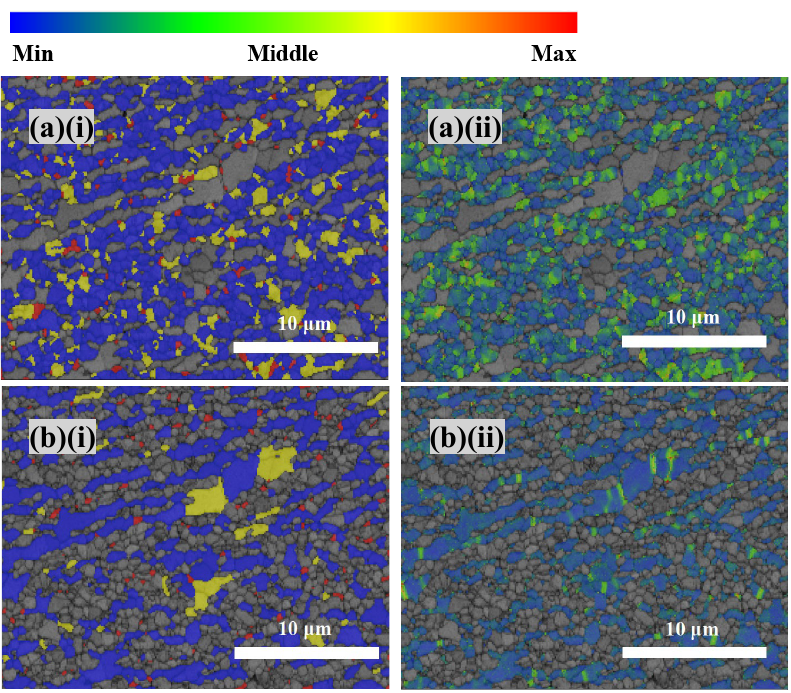
Figure 15. EBSD micrographs of ( a ) austenite and ( b ) ferrite showing: ( i ) RF and ( ii ) KAM maps.